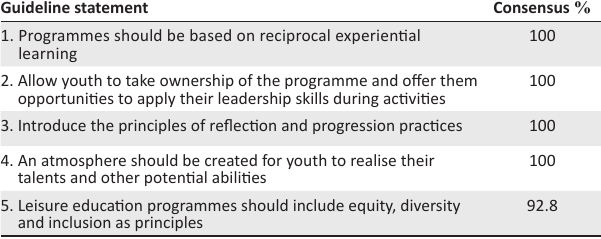
TABLE 5: Guidelines on how leadership skills can be developed during leisure education